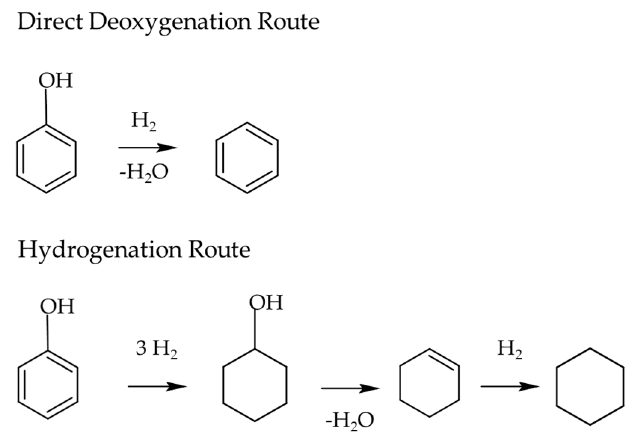
Figure 11. Proposed HDO pathways for phenol reported by Engelhardt.